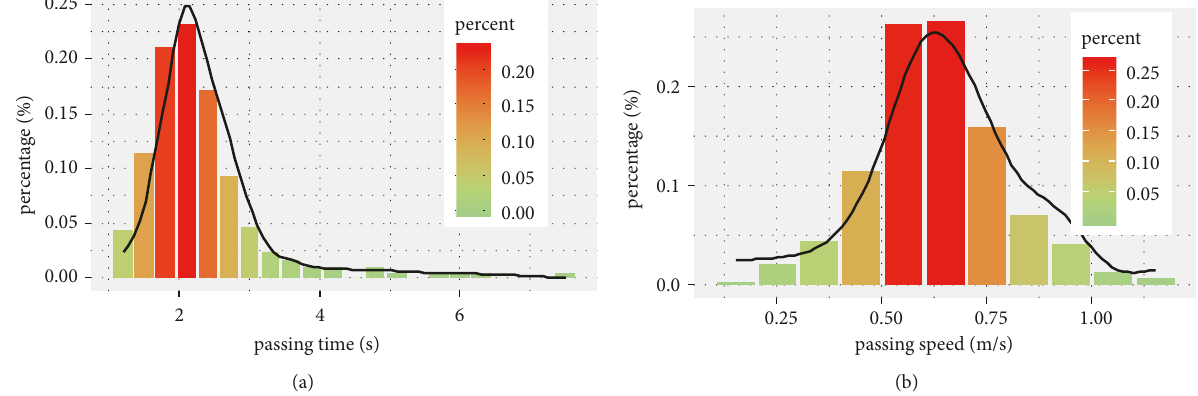
Figure 7: (a) The time of passing through a gate based on field survey and (b) the calculated passing speed.